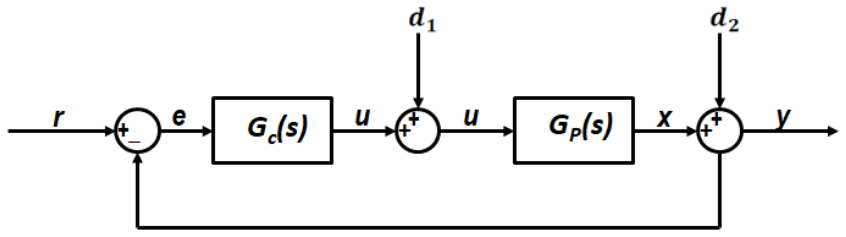
Figure A1. Block diagram of a single degree of freedom (1-DOF) PI controller.